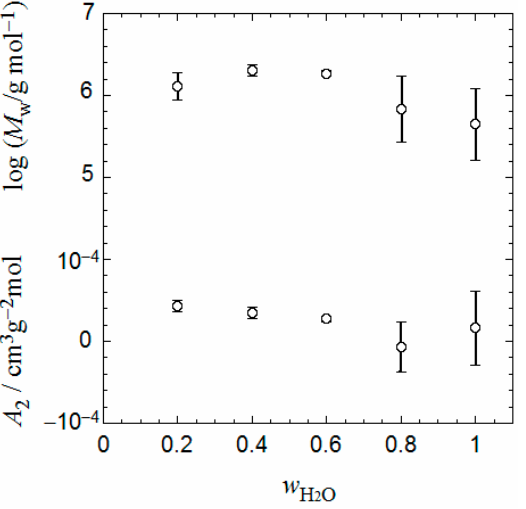
Figure 2. Solvent composition dependences of the weight average molar mass M w and second virial coefficient A 2 of PFSI at 25 °C.